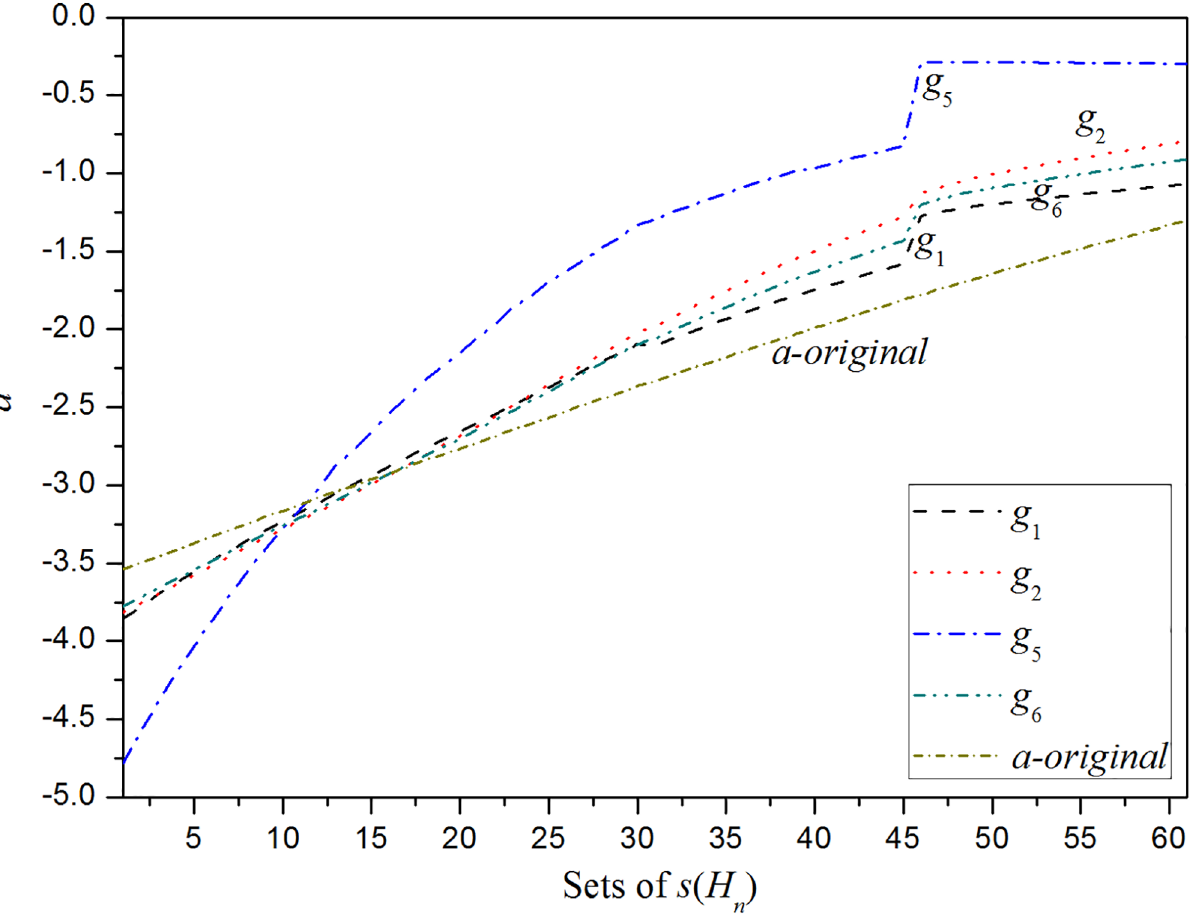
Fig 2. The comparison of the combinations of a